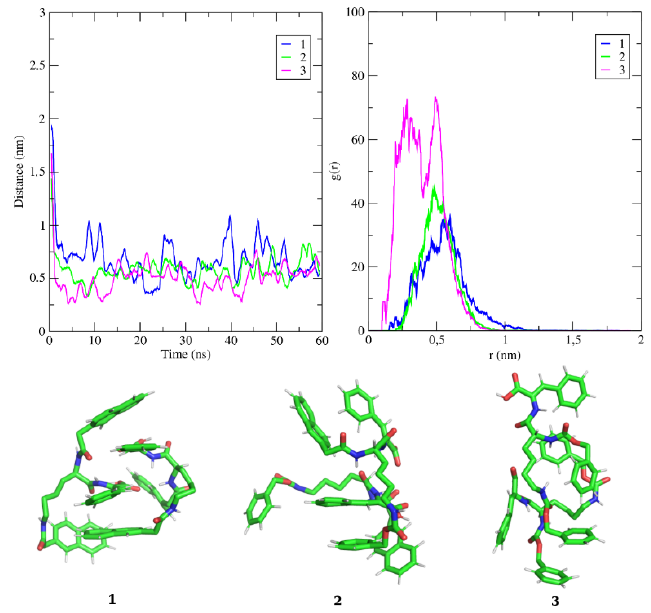
Figure 14. Centre of mass (COM) intermolecular distance between dehydrodipeptide units along simulation time; COM radial distribution functions (RDFs) of the peptides’ interaction probability density vs. distance and peptide dimers aggregation snapshots ( 1 – 3 ). The colour scheme follows the description in Figure 13.